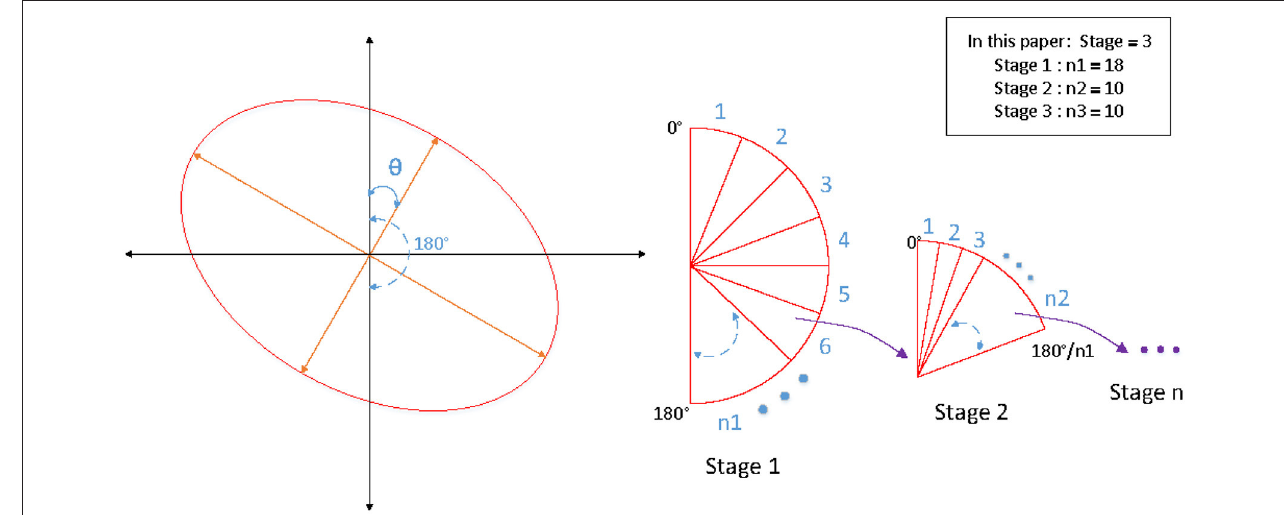
FIGURE 5 | The schematic diagram of SSR strategy for angle